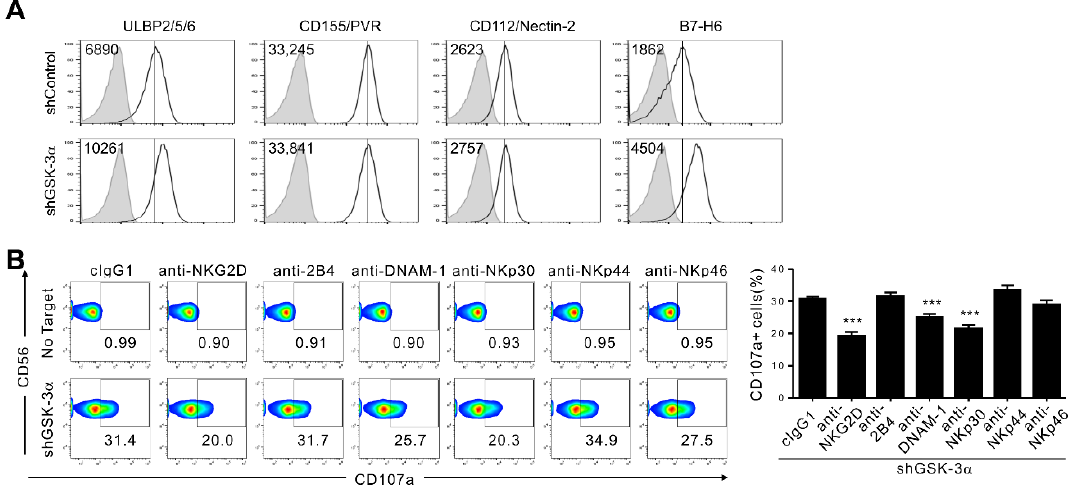
Figure 5. GSK-3 α knockdown induces the upregulation of NKp30L (B7-H6) but not DNAM-1L (CD155 and CD112). ( A ) Analysis of ULBP2/5/6, ligands of the NKG2D receptor; CD155/PVR and CD112/nectin-2, ligands of the DNAM-1 receptor; and B7-H6, the ligand of the NKp30 receptor, on KCL-22M cells transduced with control shRNA (shControl) or with stable knockdown of GSK-3 α (shGSK-3 α ). ( B ) KCL-22M cells transduced with lentivirus expressing an shRNA specific for GSK-3 α were mixed with expanded primary NK cells preincubated with blocking Abs to the indicated receptors (20 µ g/mL) for 2 h. Degranulation was measured by the expression of CD107a on CD3 − CD56 + NK cells. Representative flow cytometry profile (left) and summary graph (right) demonstrating the percentage of CD107a + NK cells. Values represent the means ± s.d. Data are representative of at least three independent experiments. *** p <